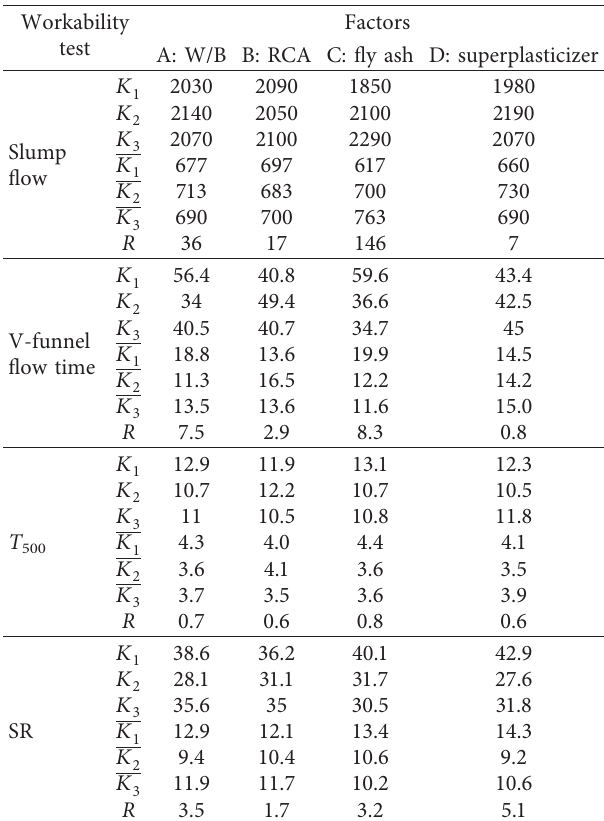
Table 10: Range method analysis of